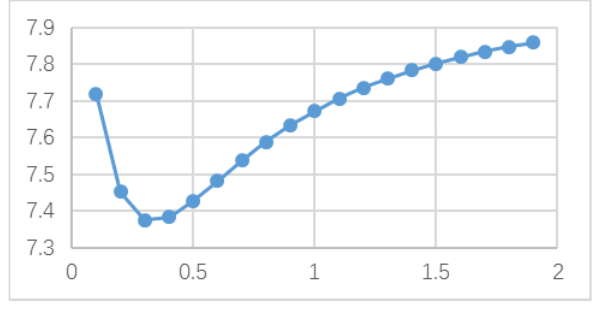
Figure 1. Entropy line